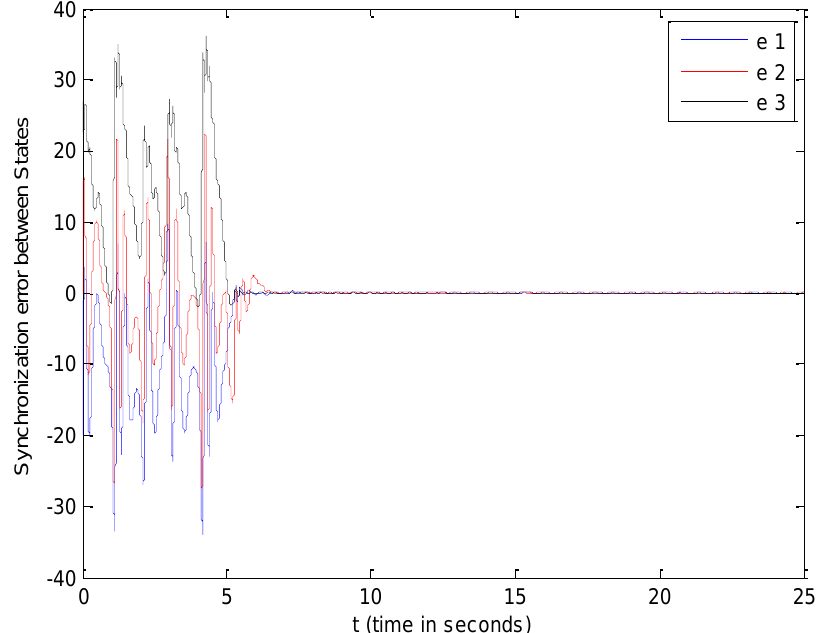
Figure 2. Anti-synchronization error between the states of master and slave systems with α i = 0.9, 𝑖 = 1, 2, and 3 , and time delay 𝜏 = 5 s.